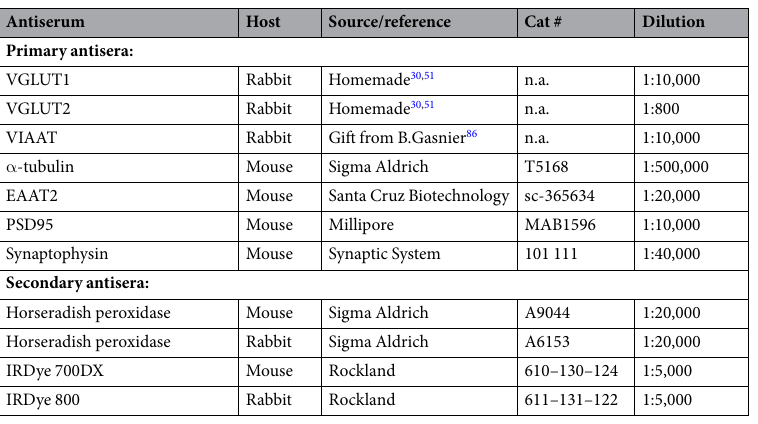
Table 4. Antisera used for western